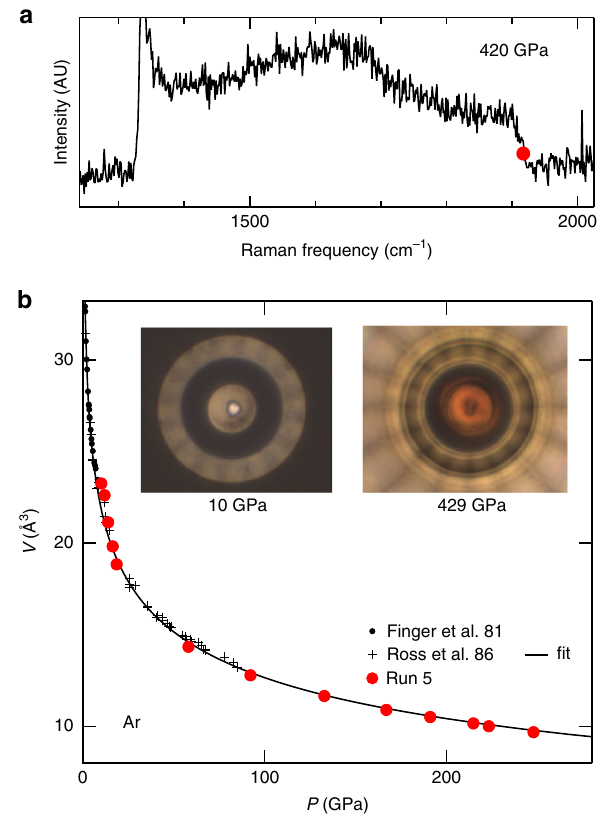
Fig. 6 Argon equation of state data. a Raman spectrum collected at the center of the toroidal-DAC at the end of run 5. The position of the high- frequency edge of the diamond anvil (minimum of the differential spectrum) is indicated by a red disc. It corresponds to a pressure of 420 GPa using the high-pressure calibration 35 . b Volume of argon measured in run 5, compared with the equation of state obtained by a fi t of lower pressure data points 51,52 (black line). Insets: photographs of the sample. The image at 429 GPa is blurred by birefringence of the diamond anvil under high stress; the red color seen on the diamond tip is attributed to the closure of the diamond band gap